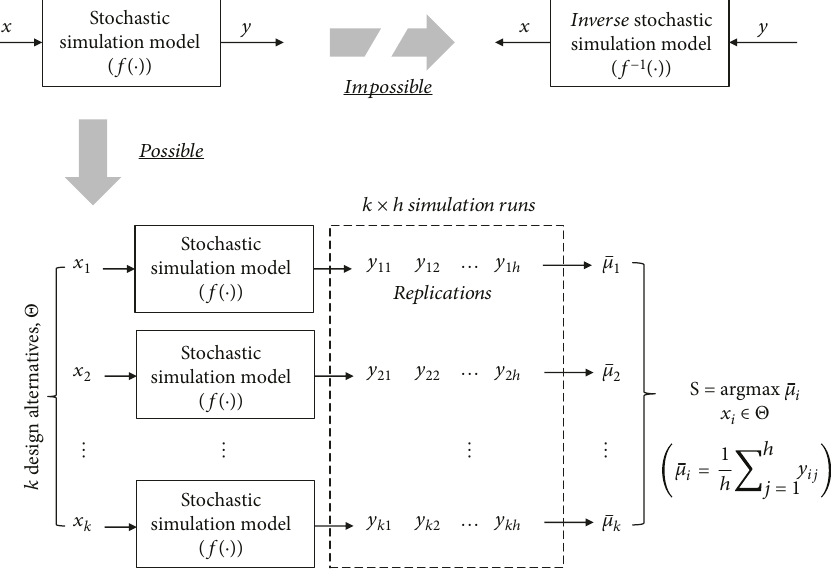
Figure 2: Optimization in the stochastic simulation model.